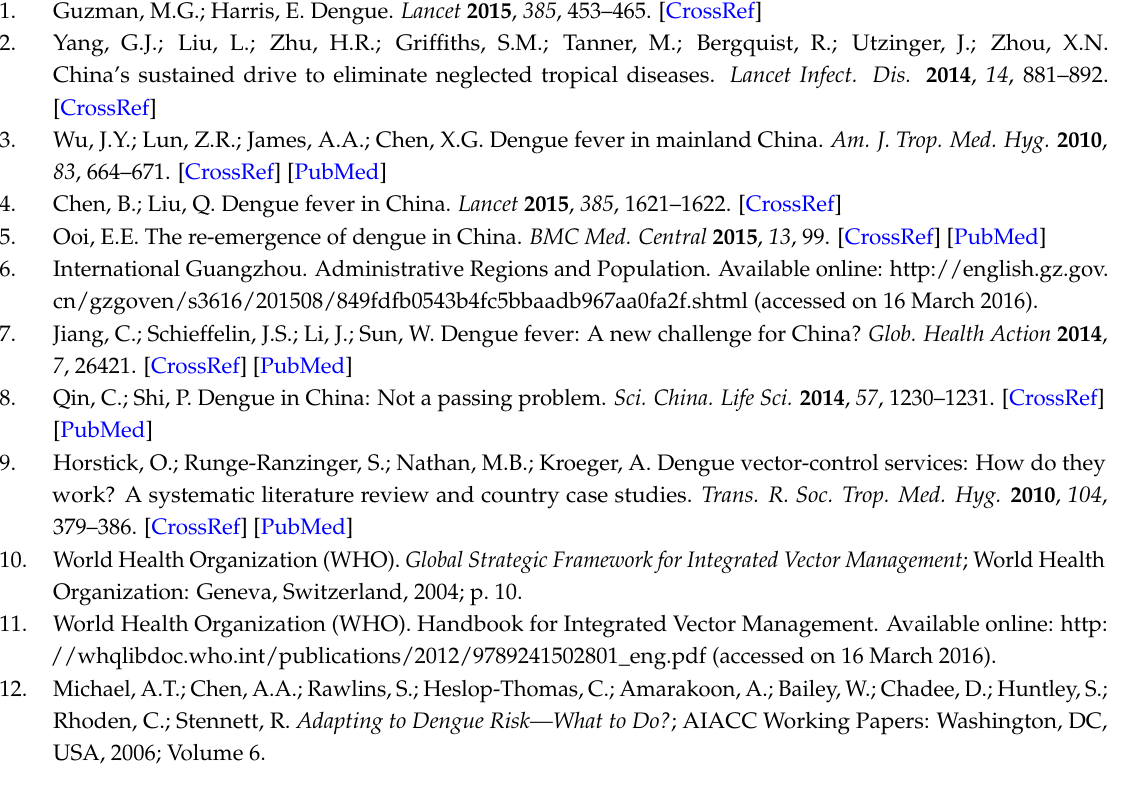
Table S1: The specification of variable assignment, Table S2: Variables not in the Equation of logistic regression. Acknowledgments: The study was supported by the National Basic Research Program of China (973